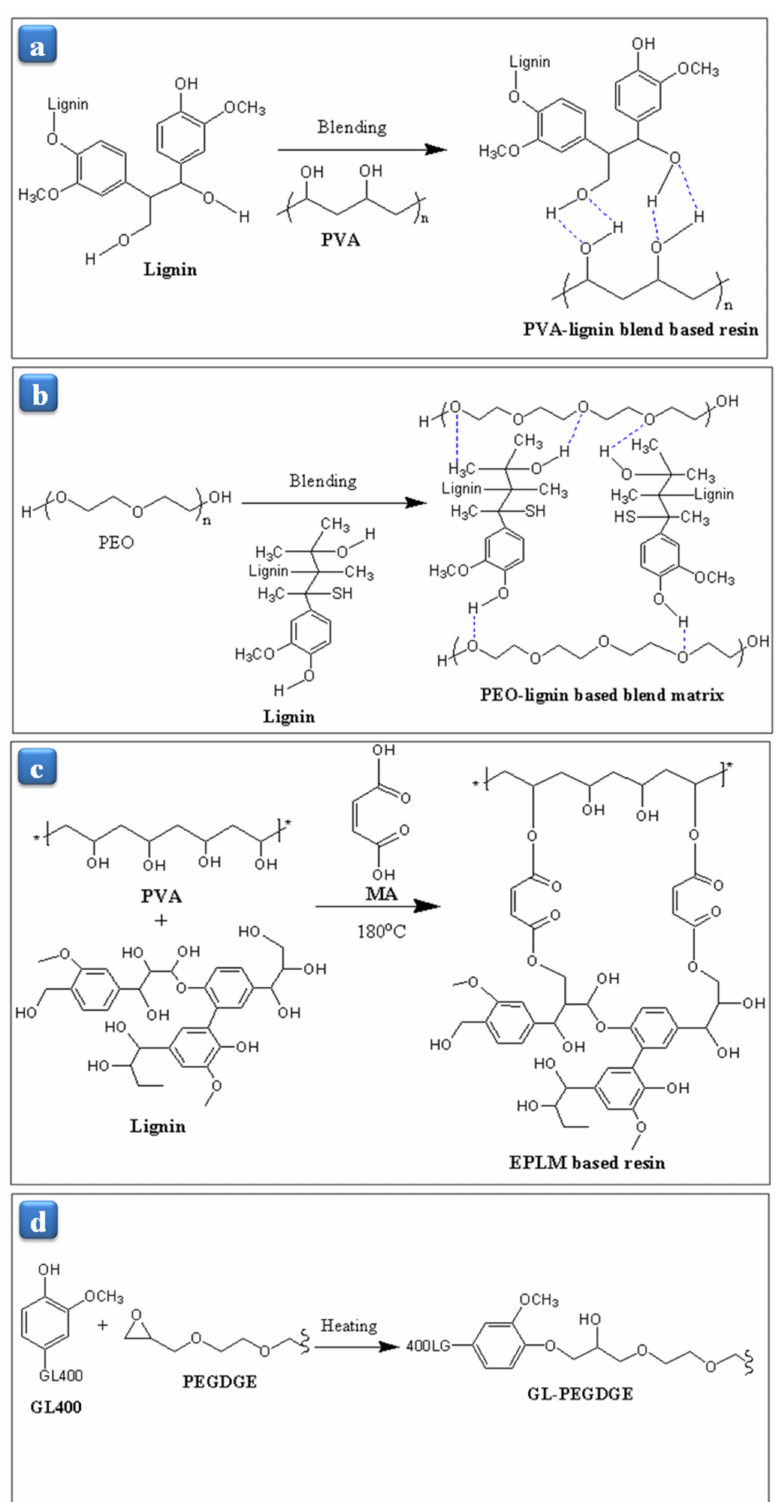
Figure 5. Schematic reaction diagram for the development of ( a ) PVA-lignin resin, ( b ) PEO-lignin blend matrix, ( c ) esterified PVA-lignin-maleic acid (EPLM) resin, and ( d ) elastomeric GL-PEGDGE